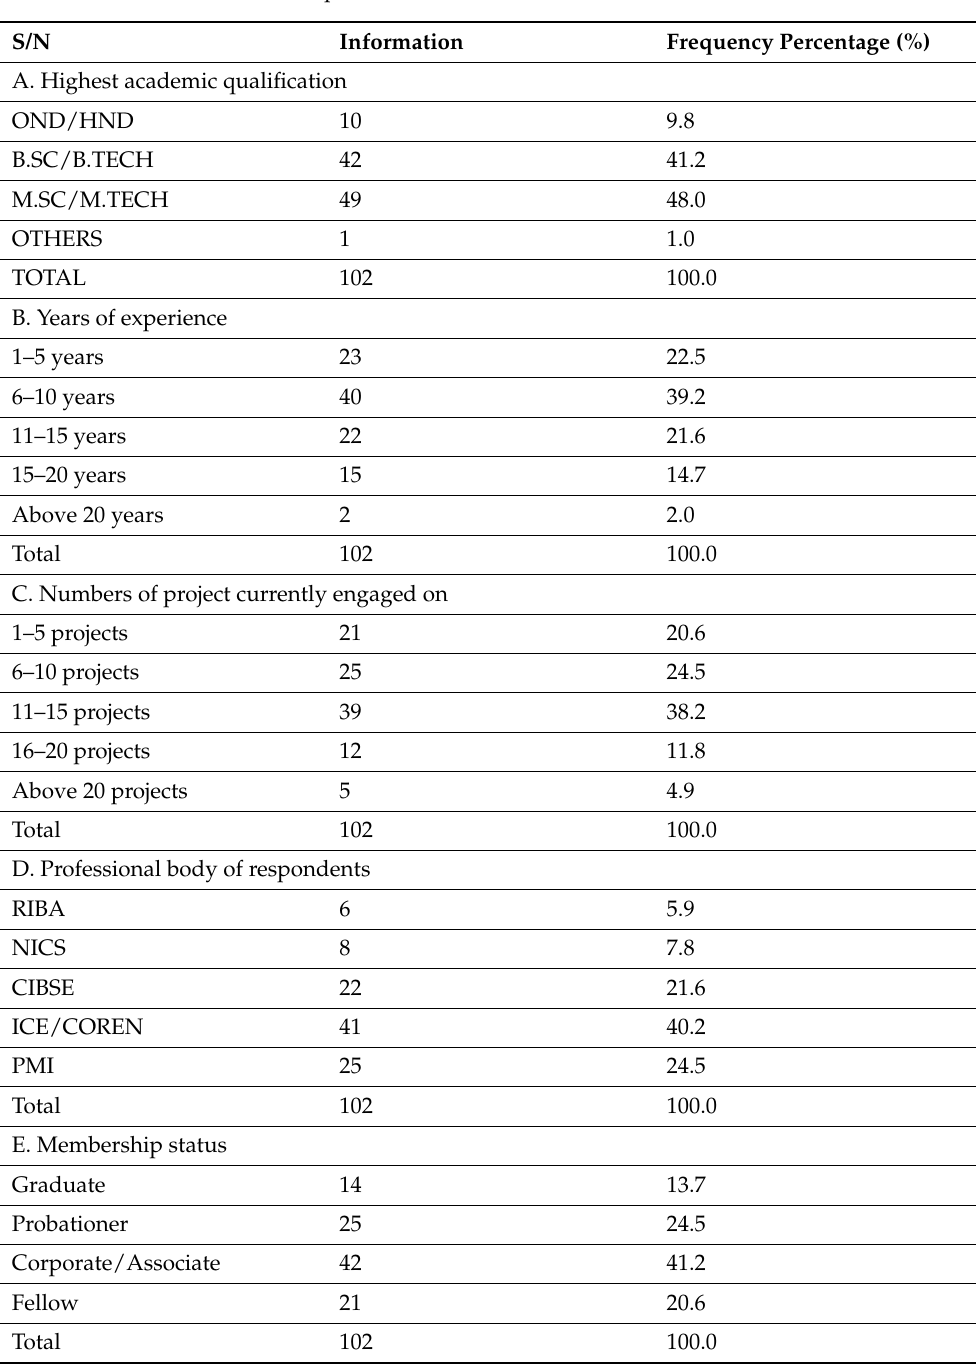
Table 2. Characteristics of the